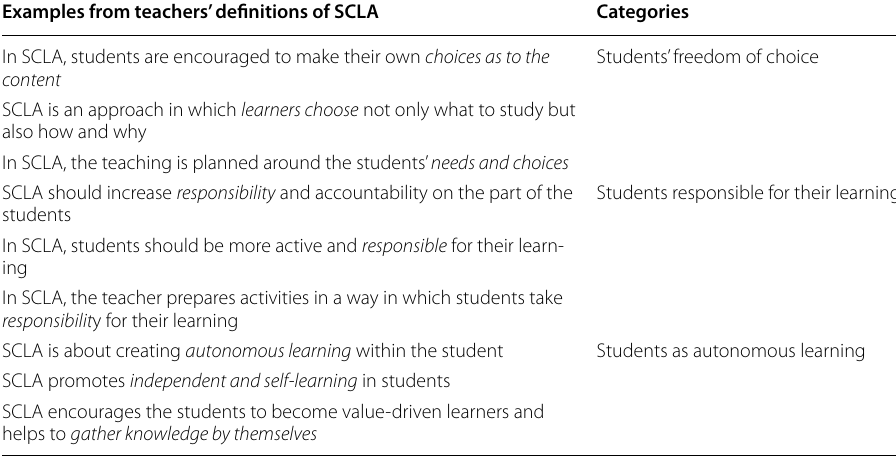
Table 6 Categories identified from teachers’ definitions of